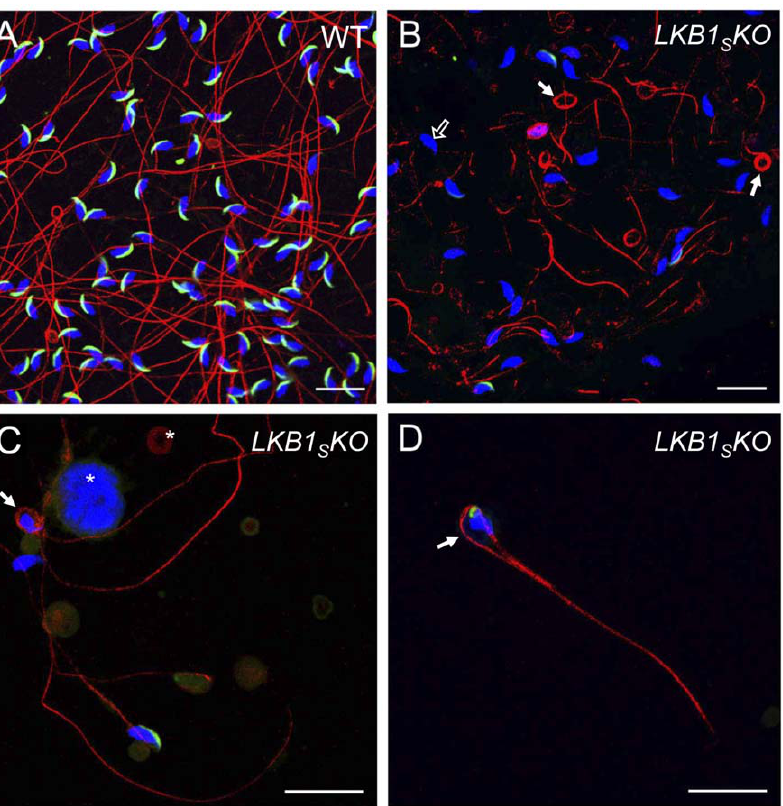
Figure 2. Fluorescence microscopy images of mature spermatozoa. Spermatozoa were taken from the cauda epididymis of wild-type ( A ) and LKB1 S KO mice ( B – D ), and visualised by immunofluorescence. Tails were stained with an anti-tubulin antibody (red), acrosomes with an anti- acrosomal monoclonal antibody (green) and nuclei with DAPI (blue). Sperm from LKB1 S KO mice frequently show coiled tails ( filled white arrows ). In ( D ), the tail has formed a ‘lasso’-type structure around an abnormally shaped nucleus. Sperm nuclei from LKB1 S KO mice often lack acrososmes ( open white arrow in B ) as shown by the lack of green fluorescence at the anterior nuclear surface. Abnormal cellular debris is visible in LKB1 S KO samples, as indicated by asterisks in ( C ). Slides were viewed on a Leica TCS SP1 confocal microscope. Images are representative of at least three mice (Scale bar =20 m M).